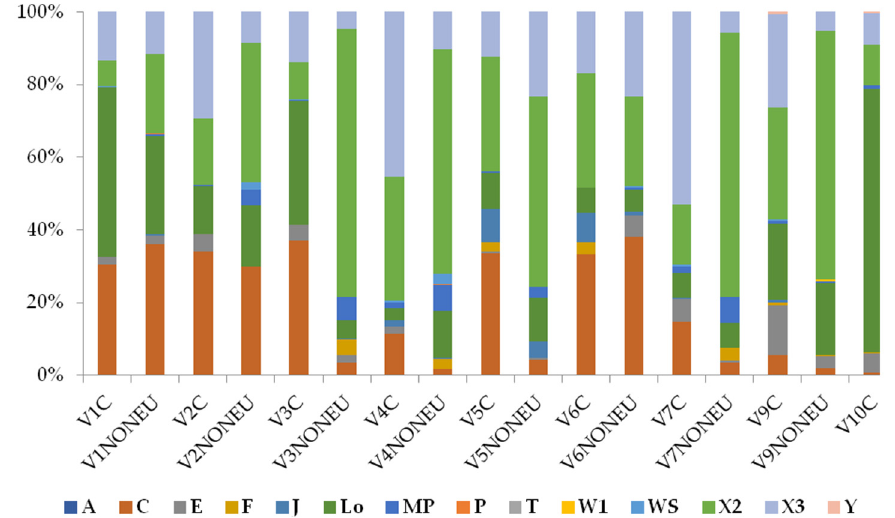
Figure 8. Relative biomass shares of Reynolds’ functional groups (expressed in percentages) in the eDNA composite (C) and aphotic zone (NONEU) samples of sampling stations (V1 to V10, excluding station V8) in Lake Visovac during August 2018.